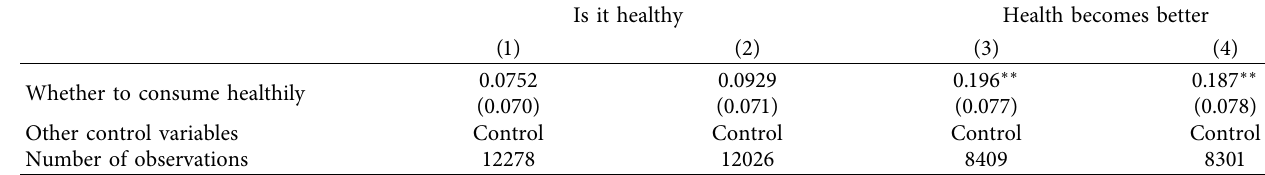
Table 6: Panel data logit regression